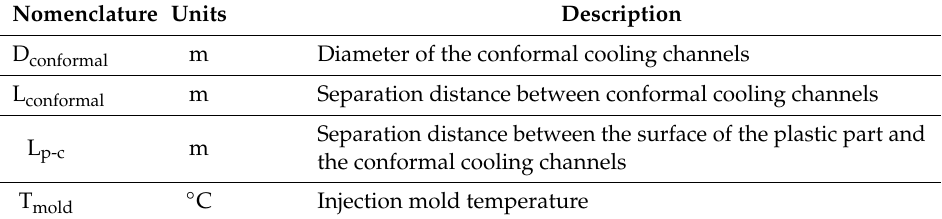
Table A1. Geometrical and technological variables for the conformal cooling channels design.